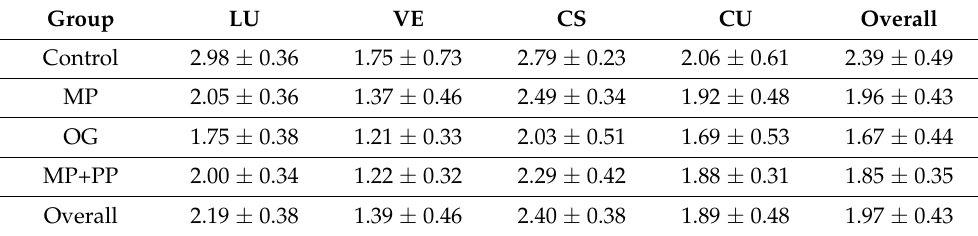
Table 4. Mean ∆ E of the materials after surface finishing protocols.